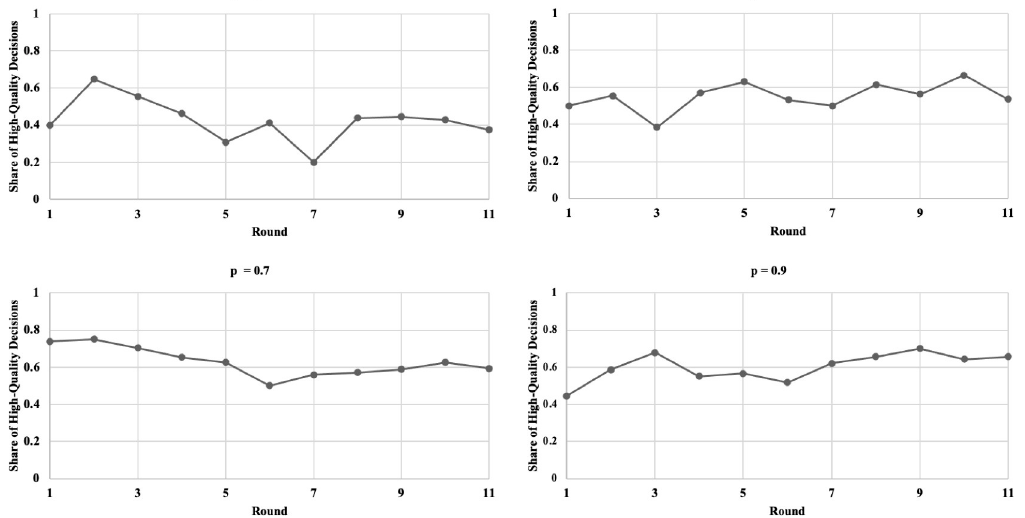
Fig 7. Share of high-quality decisions (unrealistic deadlines only) depending on the probability of facing an unrealistic deadline.